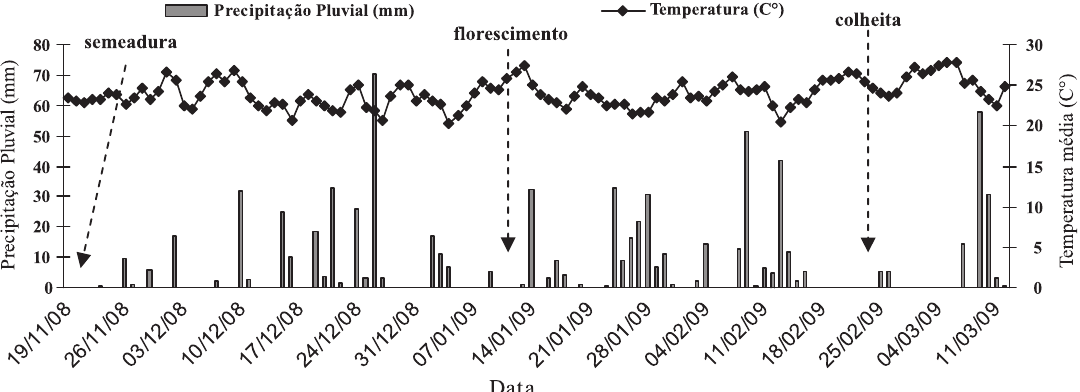
Figura 1. precipitação pluvial acumulada e temperatura média semanal durante o período de desenvolvi- mento da cultura da soja (2008/09) em jaboticabal. Fonte: depto. de ciências exatas